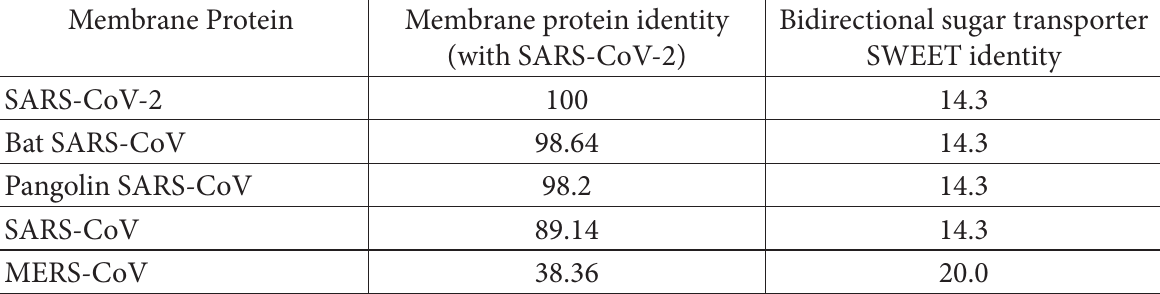
Table 1. Homology of the M protein of SARS-CoV-2 with the M protein of other coronaviruses and the sugar transporter